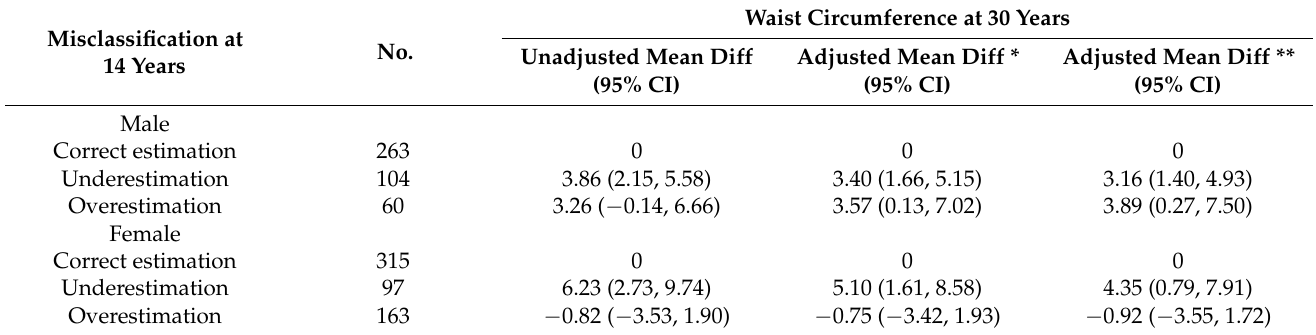
Table 3. Mean difference and 95% confidence interval of body weight misclassification at the 14-year follow-up with waist circumference at the 30-year